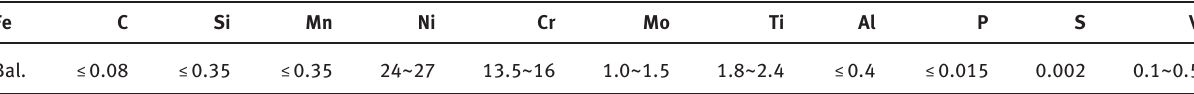
Table 1: Nominal composition of alloy A286 (mass fraction %).